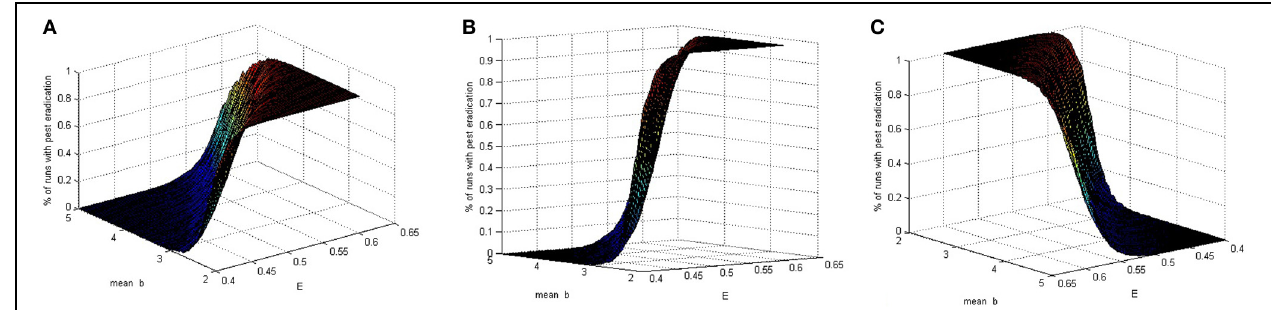
FIGURE 1 | Three views of the percentage of runs with eradication for ordered pairs ( E , b ) , where b is stochastic and E is